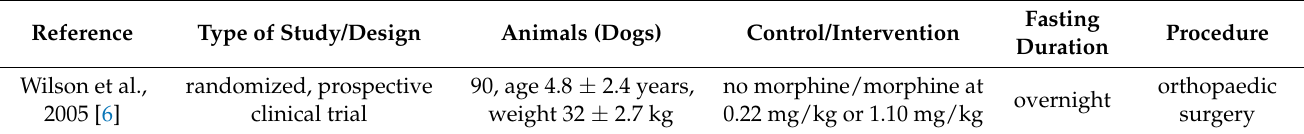
Table 4. Intervention: use of opioids. Characteristics of the study in dogs.